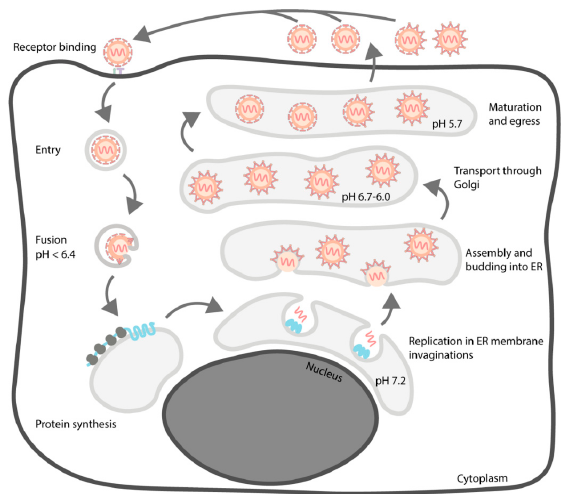
Figure 4. An overview of the TBEV life cycle. The virion interacts with a receptor on the cell surface and enters the cell via the endocytic pathway. The low pH in the late endosome triggers fusion of viral and endosomal membranes which leads to virion uncoating. Viral proteins are synthesized by the ribosomes of the rough endoplasmic reticulum (ER). Genome replication occurs in virus-induced invaginations of the endoplasmic reticulum (ER) and newly synthesized genomes are captured by C protein on the cytoplasmic side of the ER. The nucleocapsid complex acquires the structural proteins E and M and a lipid envelope by budding into the ER lumen through the membrane. The spiky immature particles are transported through the Golgi network and maturate in the acidic trans -Golgi environment after a conformational change in prM and its subsequent processing by furin. The smooth mature particles egress from the infected cell along with partially mature and immature particles. The mature and partially mature particles can start a new infection cycle but the fully immature particles are incapable of fusion and, therefore, are non-infectious.